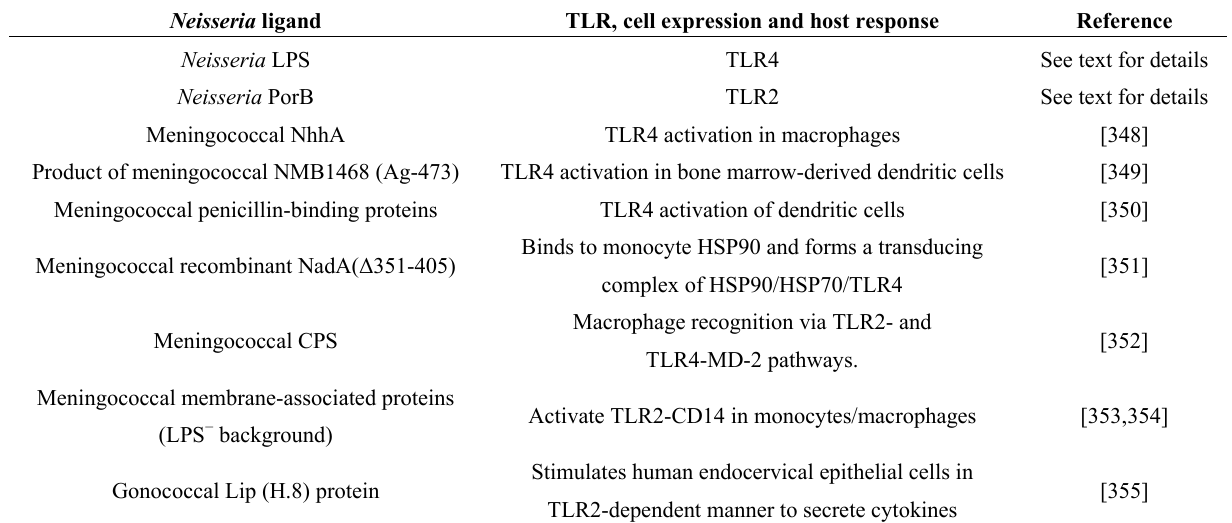
Table 2. Role of TLRs in the recognition of Neisseria